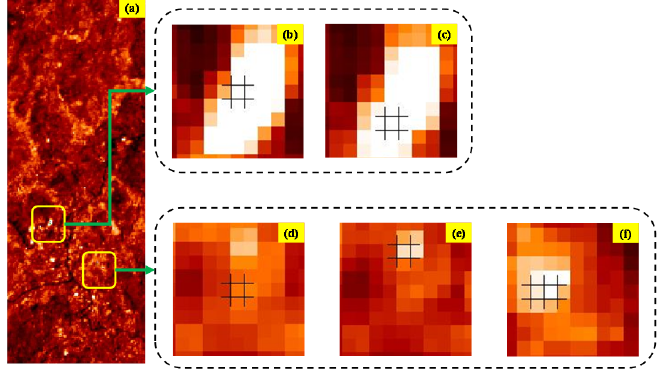
Figure 16. Target detection score image from ( a ) space-borne imagery using airborne target reference spectrum and the enlarged detection score footprint for ( b ) N3Y, ( c ) N4B, ( d ) N1G, ( e ) N2R, and ( f ) C1W target.